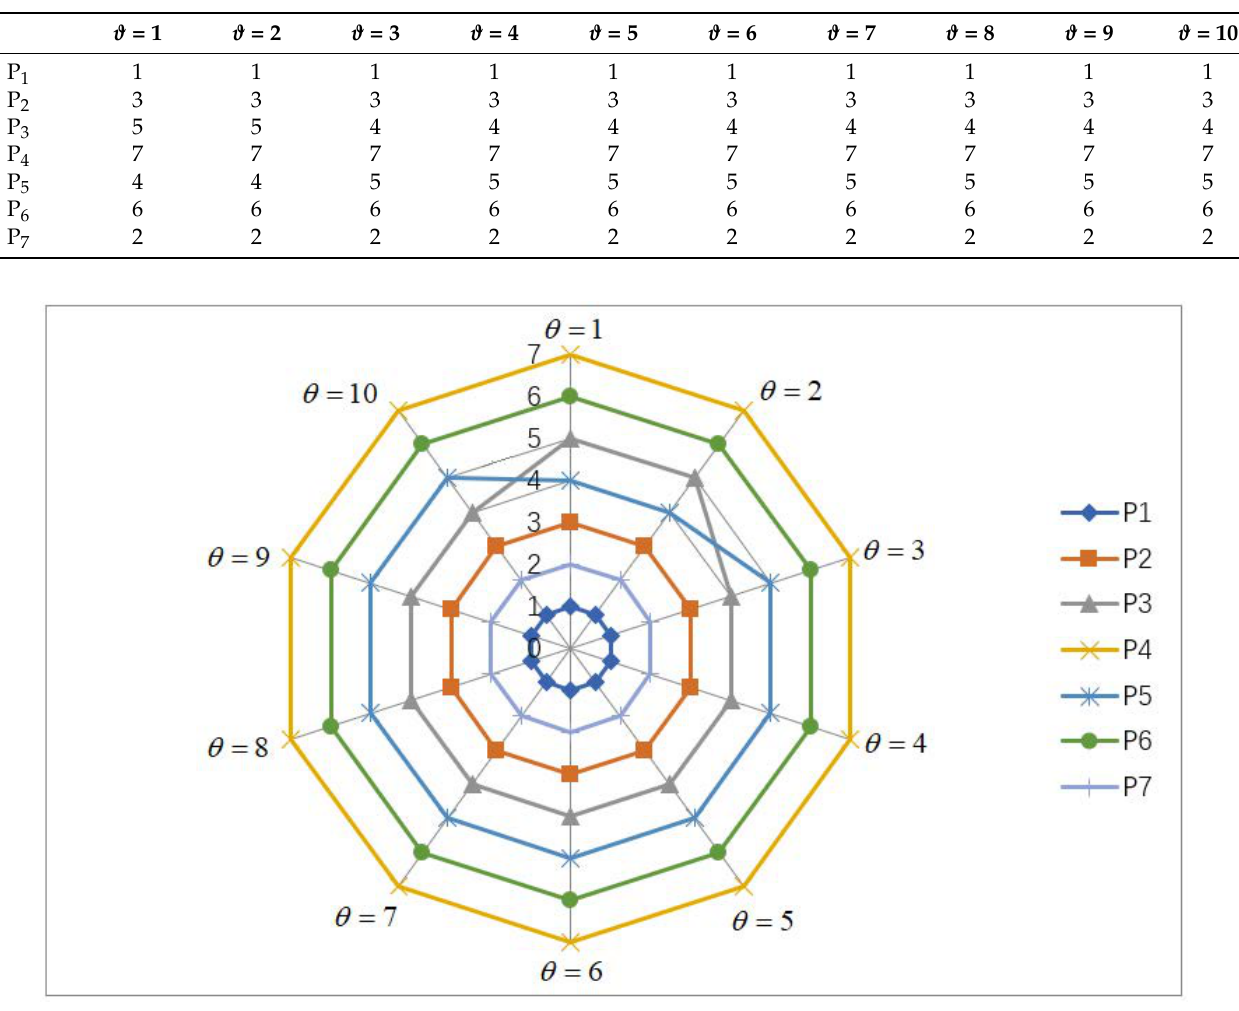
Figure 3. The ranking change in decision results under different parameter ϑ